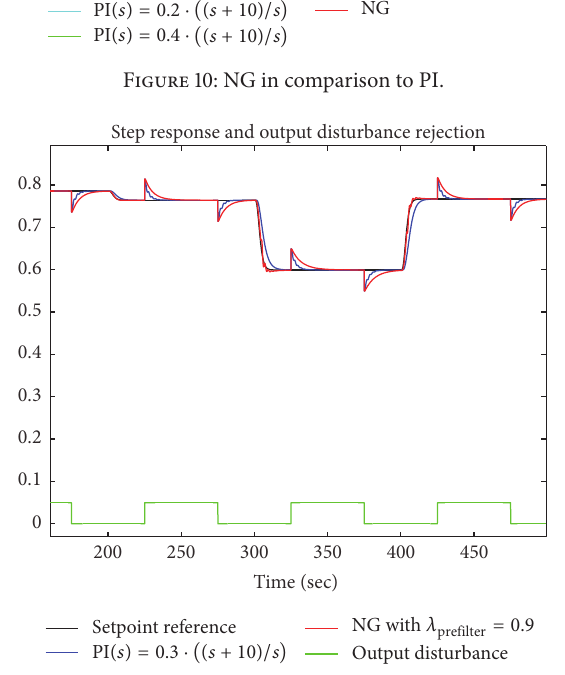
Figure 11: Disturbance